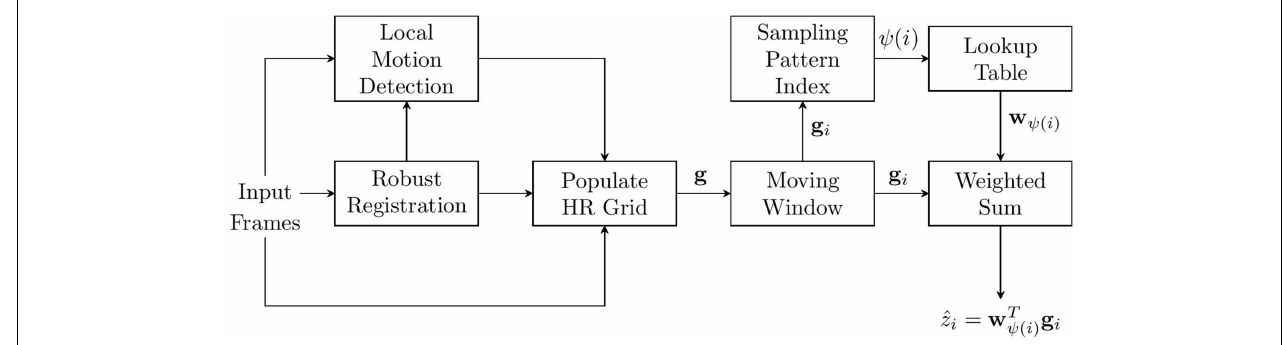
FIGURE 20 | Robust AWF SR. A weighted sum of sampled from all registered frames are used for each observation window. In areas where local motion is detected, only samples from the reference frame are used.